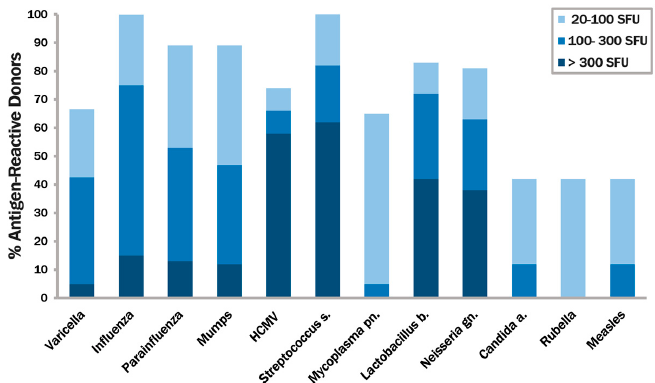
Figure 1. Initial screening of 16 donors with 12 ubiquitous antigenic systems. The antigens specified on the x-axis were tested on peripheral blood mononuclear cells (PBMC) of 16 donors in an interferon (IFN)- γ ELISPOT assay. The percentage of PBMC donors responding to each antigen is shown while also grading the magnitude of the response as specified.